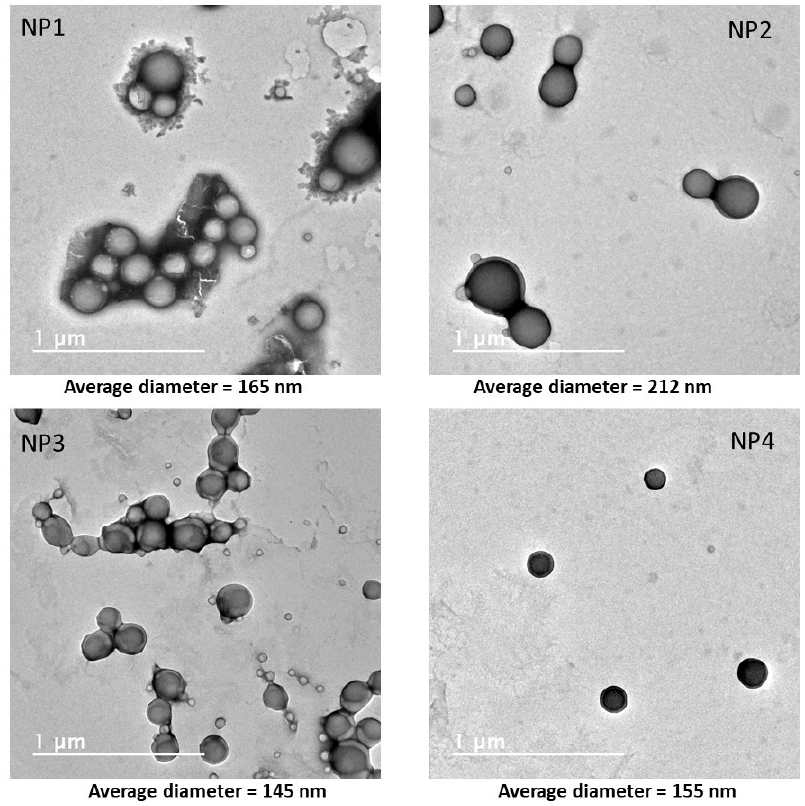
Figure 1. TEM images of porphyrins-loaded NPs.